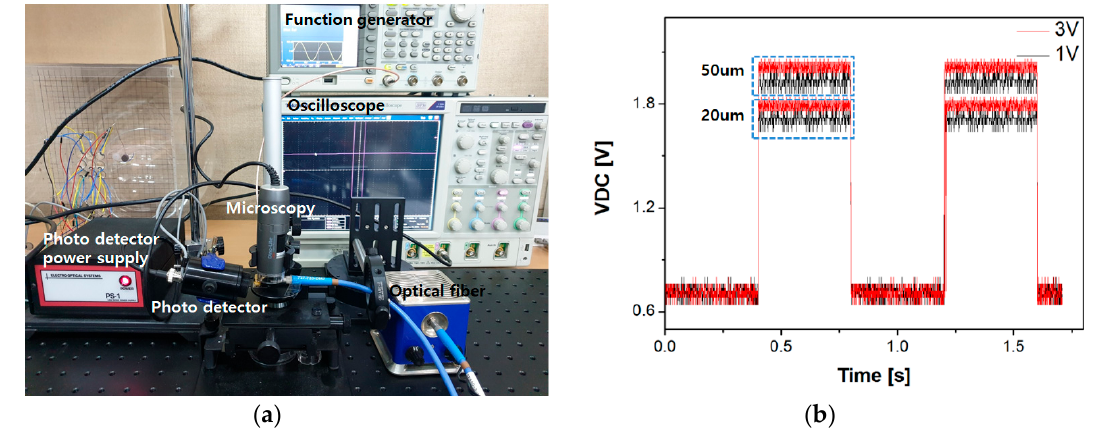
Figure 10. ( a ) Measurement setup for the diffraction efficiency after placing a photodetector at the first order beam position and ( b ) output voltage of photodetector before and after beam diffraction.